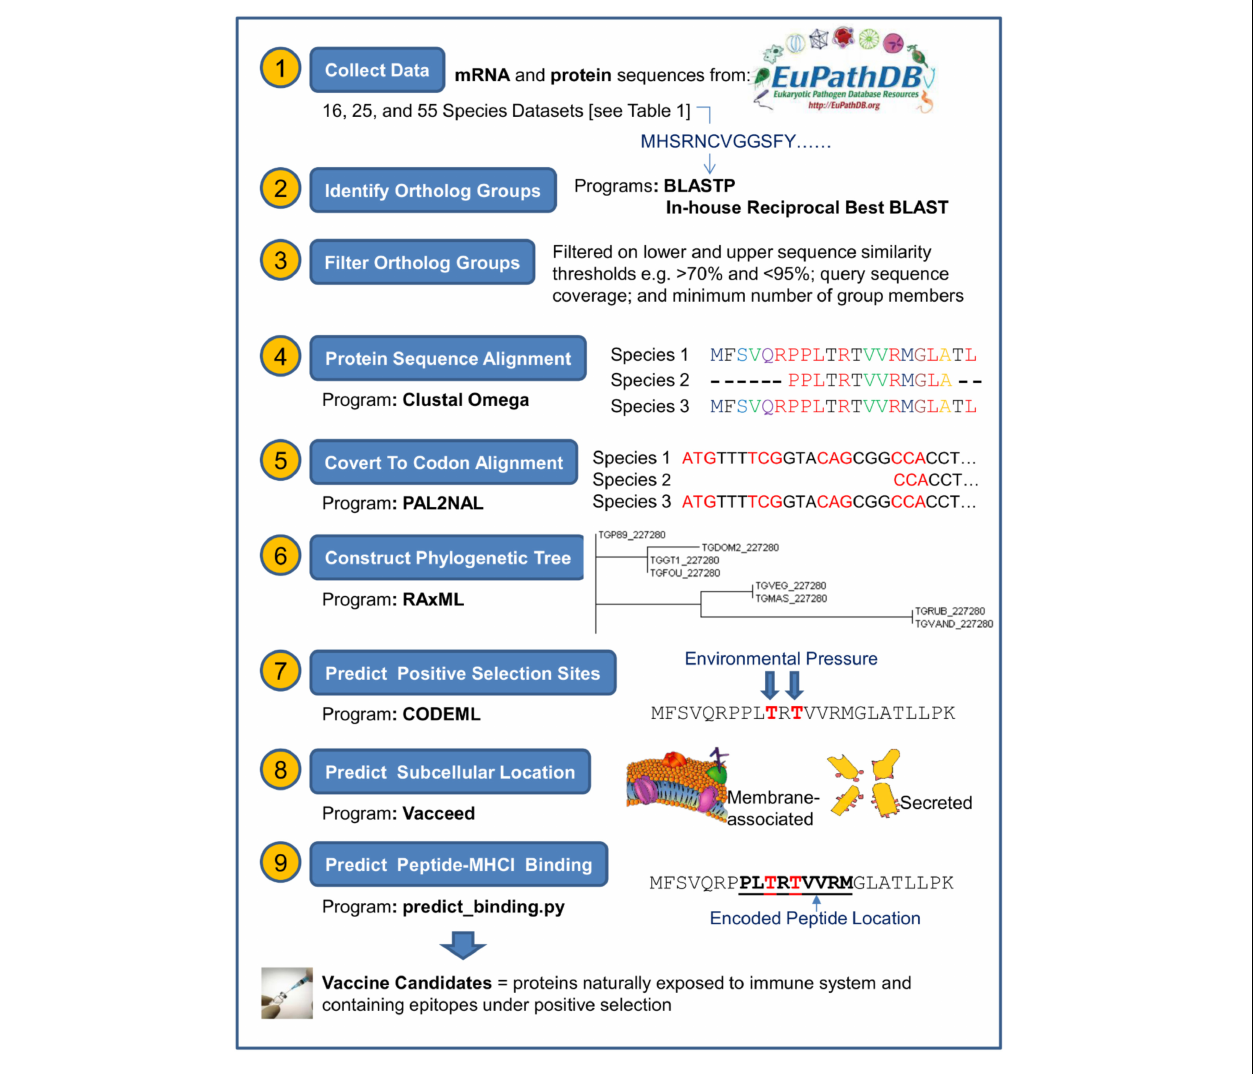
FIGURE 1 | Schematic of steps taken to predict vaccine candidates given proteins sequences from a target pathogen. This figure represents an overview of the steps and programs used to ultimately classify those proteins that are naturally exposed to the immune system and contain regions encoding major histocompatibility complexes (MHC) binding peptides under positive selection. Further program details are shown in Table 2 and Supplementary Table S1